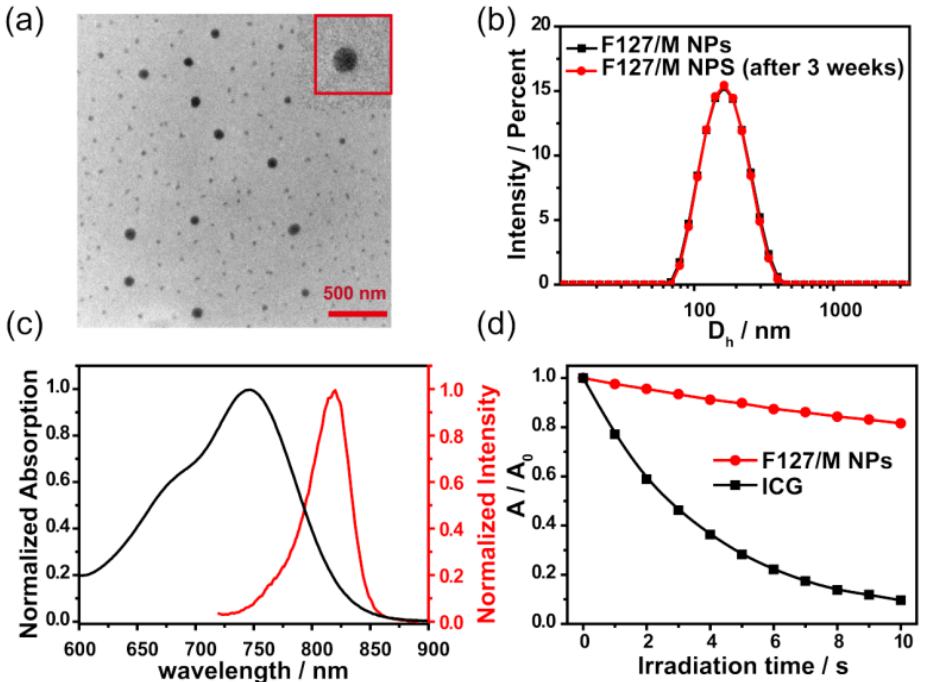
Figure 2. ( a ) TEM image and ( b ) DLS results for F127/ M NPs immediately after preparation and after three weeks of storage. ( c ) Normalized UV–vis absorption and fluorescence spectra of the NPs in water ( λ ex = 660 nm). ( d ) Relative absorption changes recorded for aqueous solutions of F127/ M NPs or ICG at 745 or 779 nm, respectively, over different irradiation times (660 nm, 1.0 W/cm 2